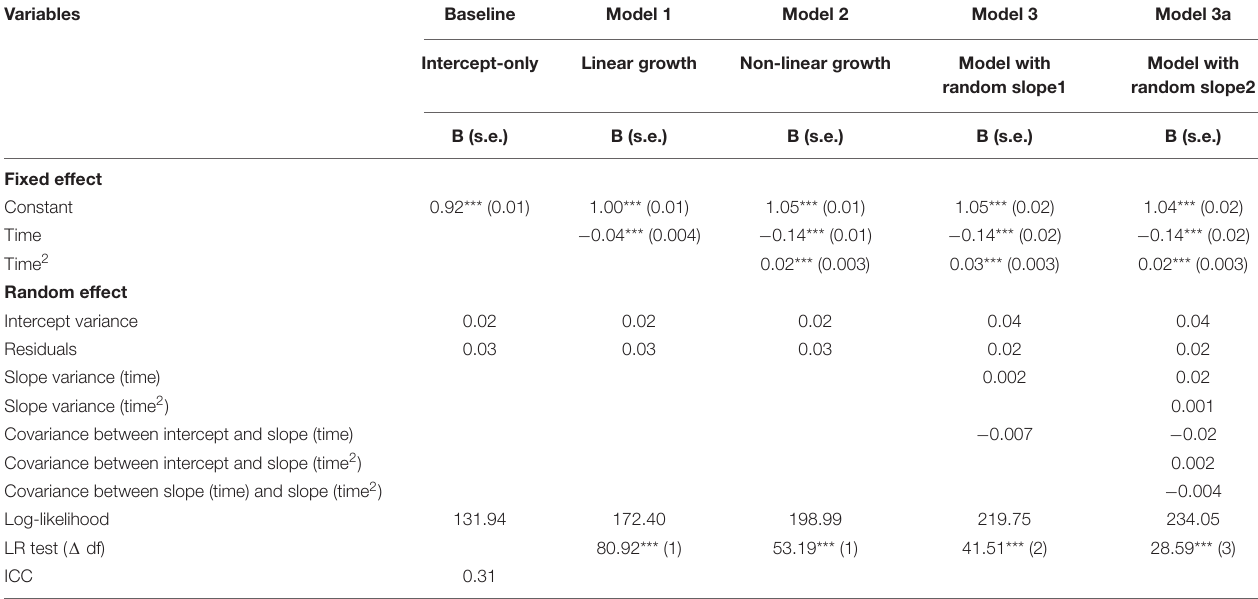
TABLE 7 | Cohort 2: results of ME growth models for changes in ANS RT (in sec.) from grade 5 to grade 9.